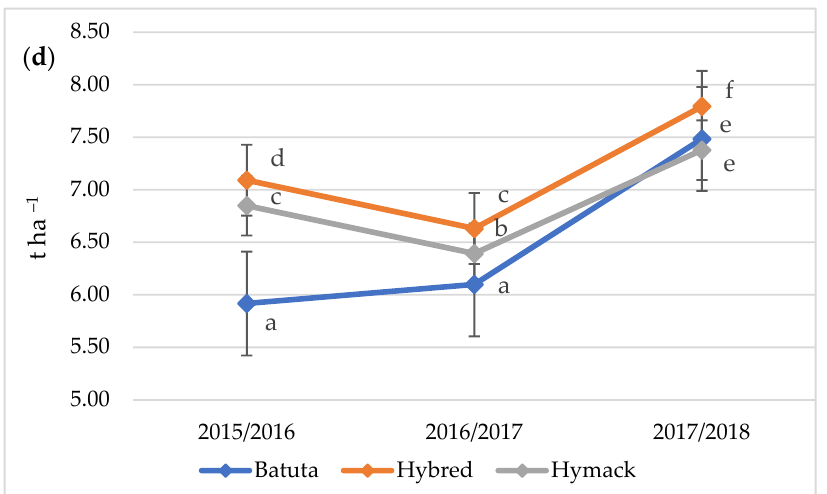
Figure 3. Wheat grain yield—interactions between experimental factors: ( a ) cropping system × loca- tion (CS × L); ( b ) cultivar × location (C × L); ( c ) location × year of research (L × Y); and ( d ) cultivar × year of research (C × Y). Different letters show significant differences between means (according to the Tukey test p < 0.05). ORG—organic system; INT—integrated system; CON—conventional